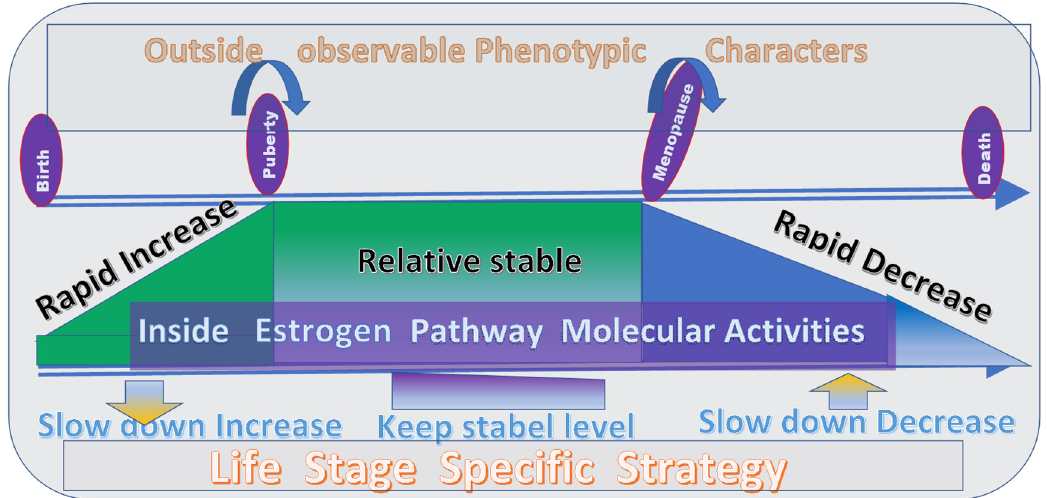
Figure 3. Life stages and strategies to extend the female lifespan. The upper section shows the phenotypic changes at different life stages. The middle section shows the physiological and biological alterations inside the body during the transition of different life stages. The bottom section shows the proposed life-stage-specific strategies to extend the lifespan of males.